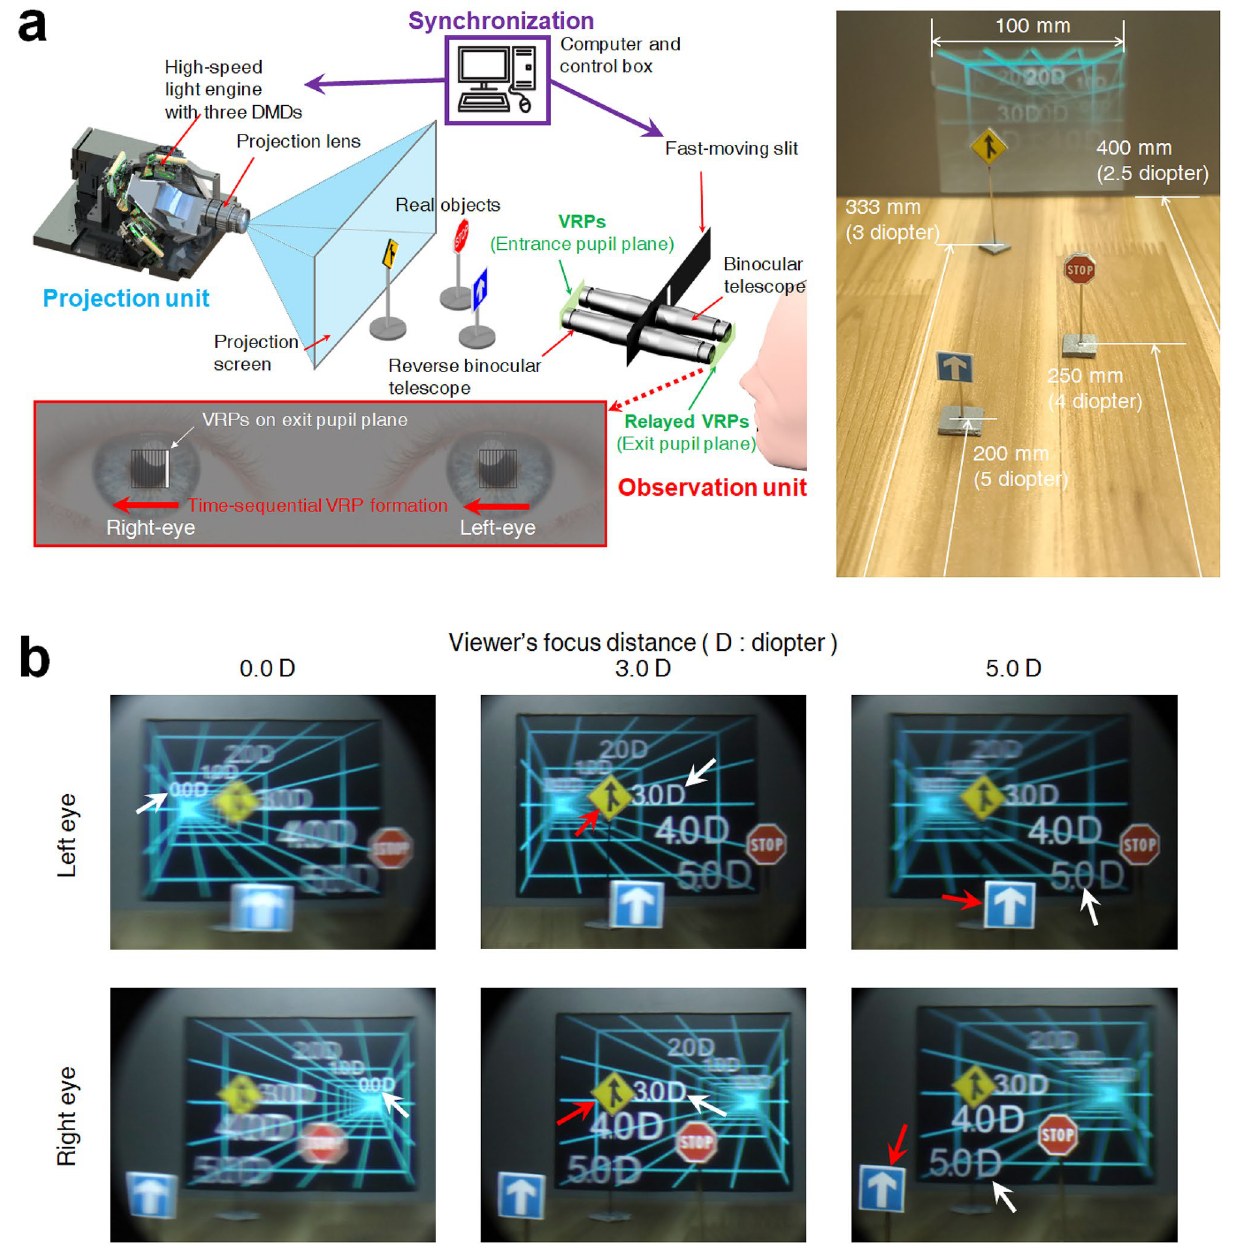
Figure 1. Augmented reality (AR) 3D image free of vergence-accommodation conflict (VAC) over a wide range of viewer’s focus distance. ( a ) Binocular time-sequential high-density super-multiview (BTS HDSMV) projection setup and target object space, and ( b ) binocular SMV-based VAC-free binocular 3D images. The SMV density of eleven views is provided to the viewer’s left and right pupils. VAC is totally eliminated from the 5.0 diopters to 0.0 diopters (see Visualization